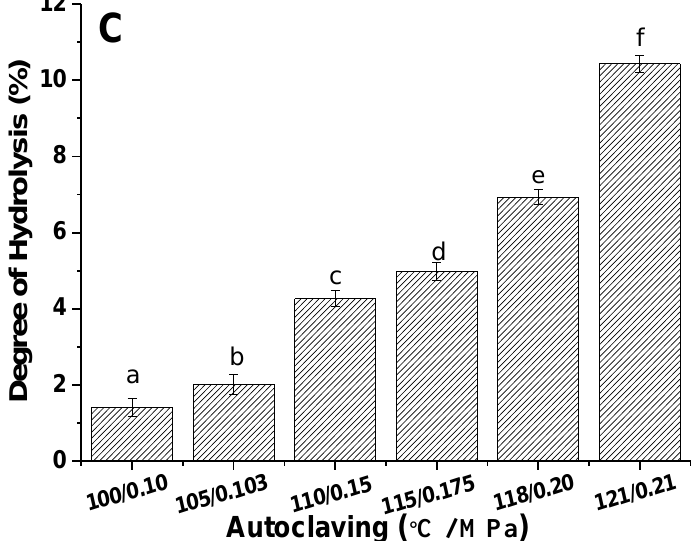
Figure 2. Change in proteins in CMP gel after various autoclaving: ( A ) SDS-PAGE of centrifugal solutions from various CMP gels; ( B ) SDS-PAGE of various CMP gel matrixes; ( C ) Degree of CMP hydrolysis, the letters from “a”–“f” indicates the significance of DH difference after various autoclaving ( p < 0.05).